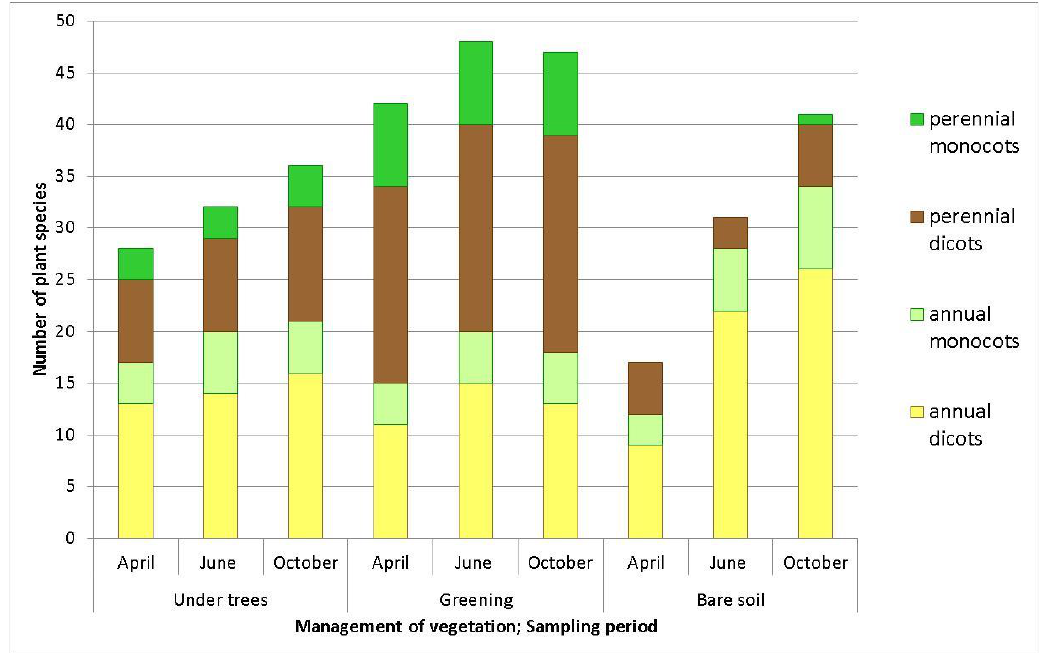
Figure 3. The number of plant species at different management and monitoring dates in the